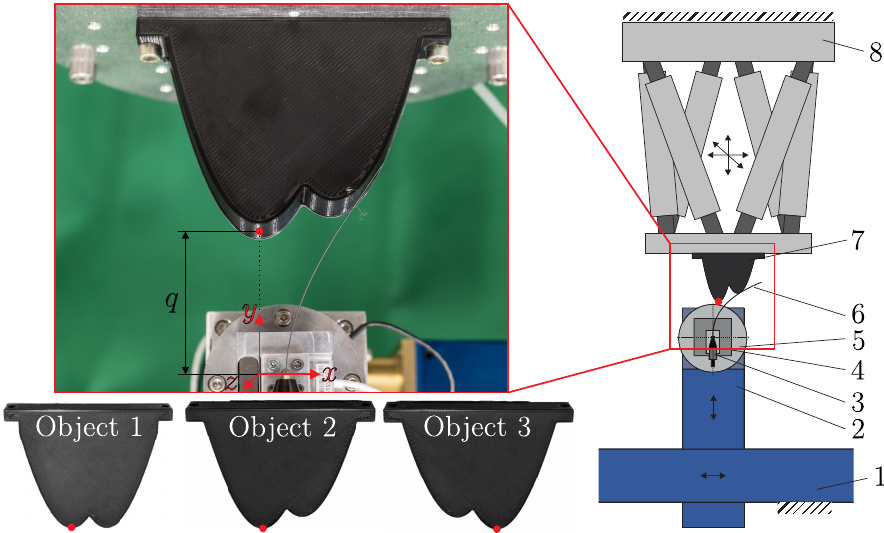
Figure 3. Experimental setup: 1, 2 – linear guides; 3 – jaw chuck; 4 – force sensor; 5 – torque sensor; 6 – spring steel wire; 7 – object, 8 –